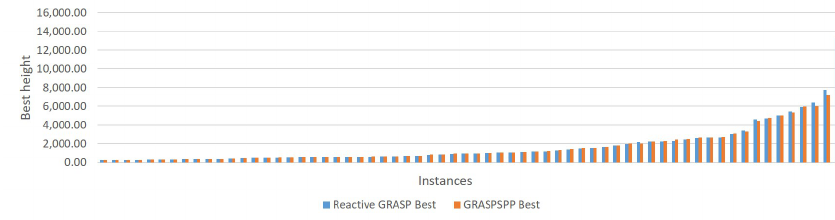
Figure 16. Best values comparison between GRASPSPP and reactive GRASP, part